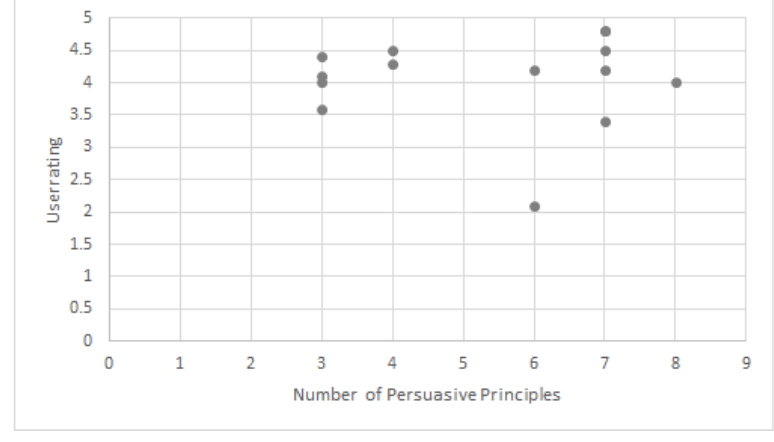
Figure 4. Number of persuasive principles in relation to user rating